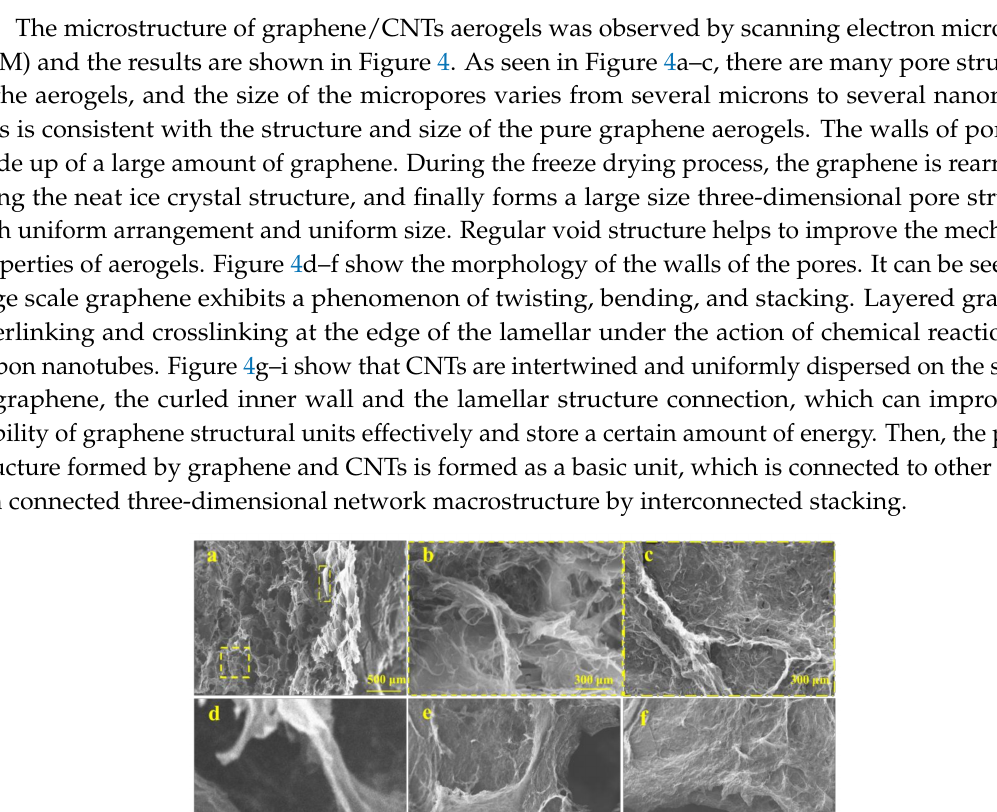
Figure 3. The macrostructure of graphene/CNTs aerogels.